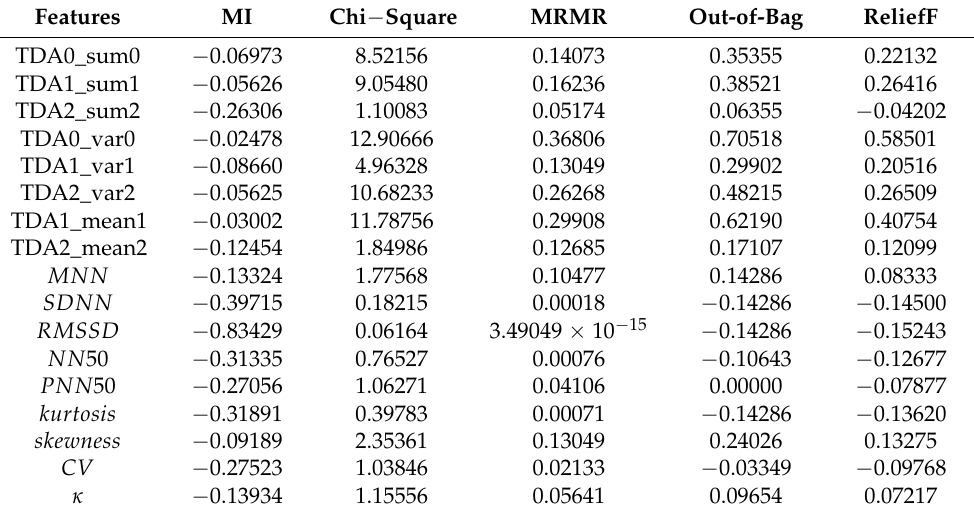
Table 6. Predictor importance scores for five features selection methods.